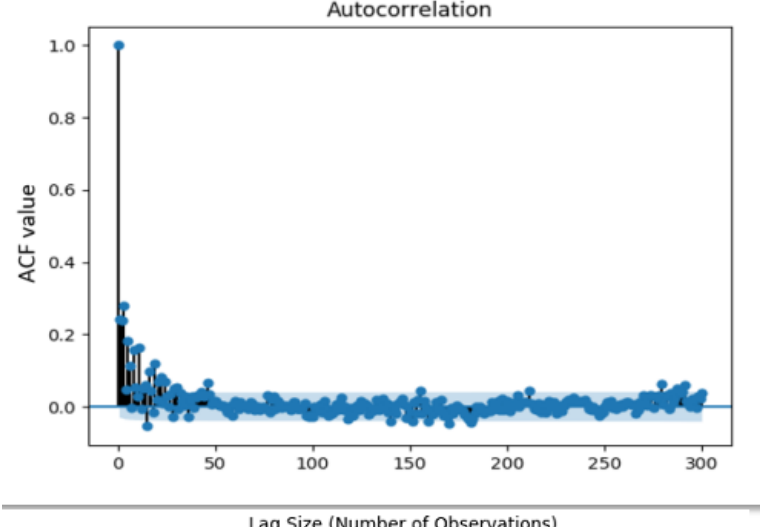
Figure 4. Autocorrelation plot for the office data. The vertical axis shows the ACF value. The hori- zontal axis of the plot shows the size of the lag between the elements of the time